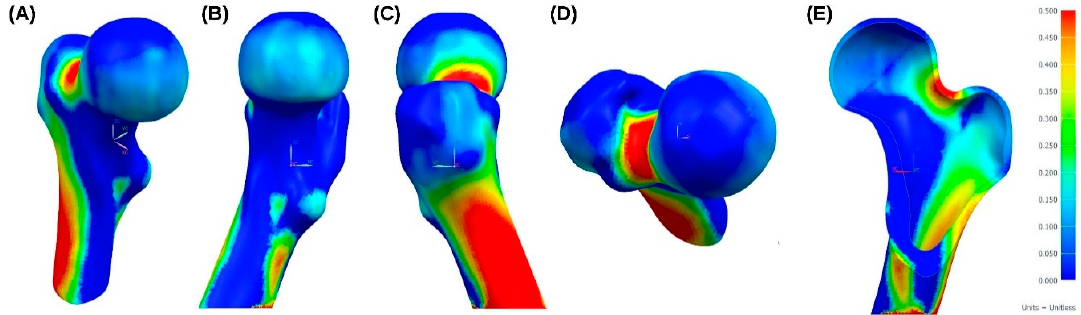
Figure 17. ( A ) Isometric, ( B ) right, ( C ) left, ( D ) top and ( E ) back view of Tsai–Wu field in proximal femur when applying the ISO force.